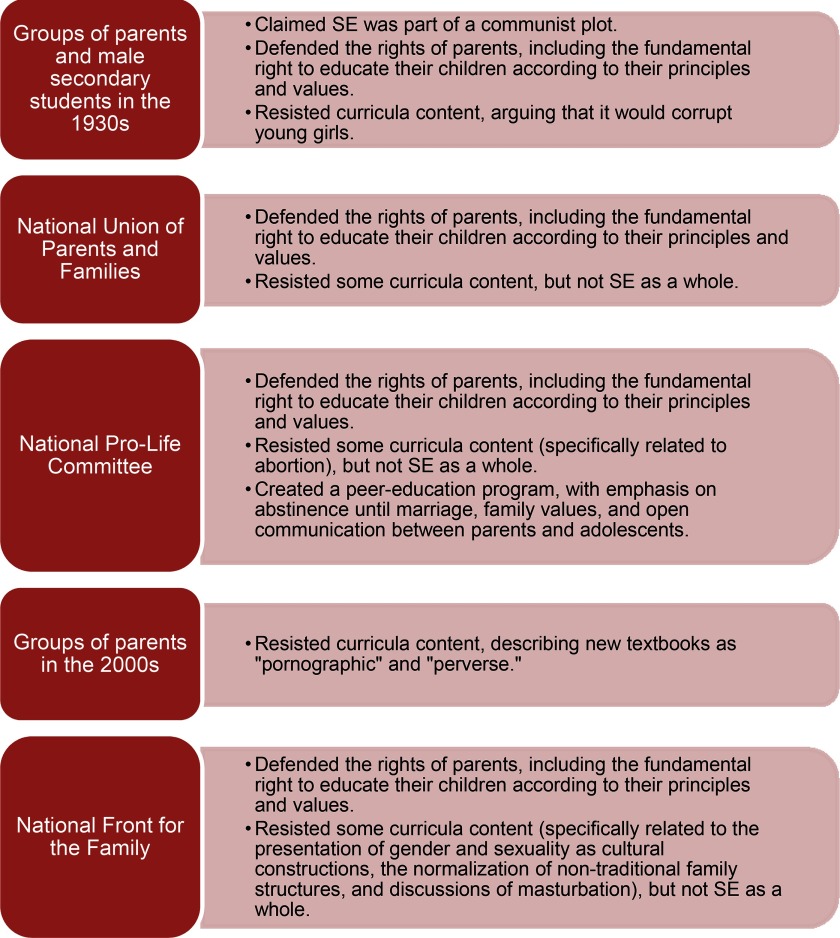
Opposition Groups and Their Rationale for Resistance to Sexuality Education